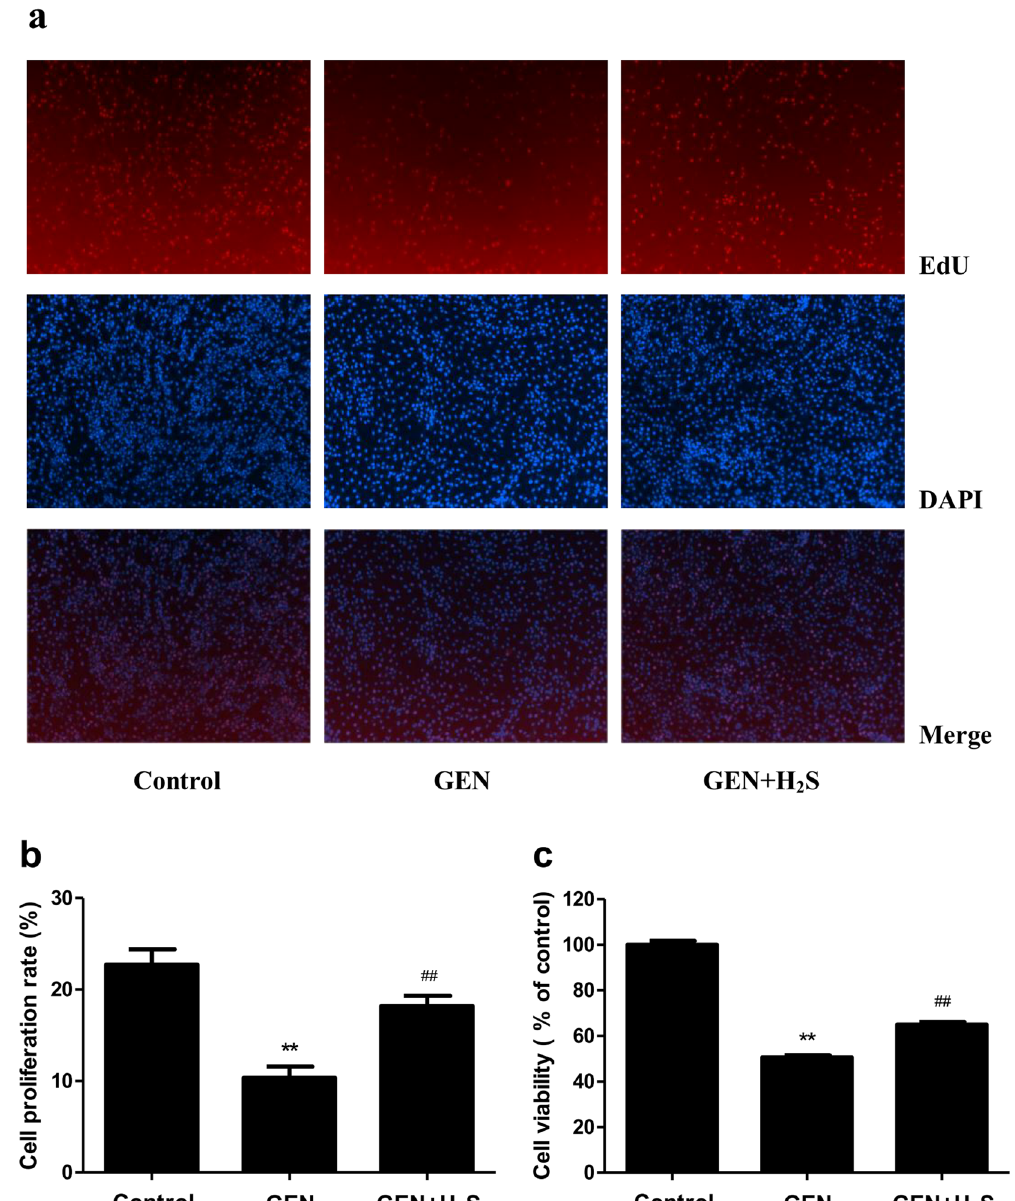
Figure 1. Effects of H 2 S on the viability and proliferation of the GEN-treated NRK-52E cells. ( a ) The cell proliferation was determined by EdU assay. The proliferative cell nuclei were stained by EdU assay with red, and all nuclei were stained by DAPI with blue (original magnification, × 100). ( b ) The cell proliferation rate was calculated. ( c ) The cell viability was detected by MTS assay. Values were presented as mean ± SEM (n = 6); * P < 0.05, ** P < 0.01 compared with the control group; # P < 0.05, ## P < 0.01 compared with the GEN